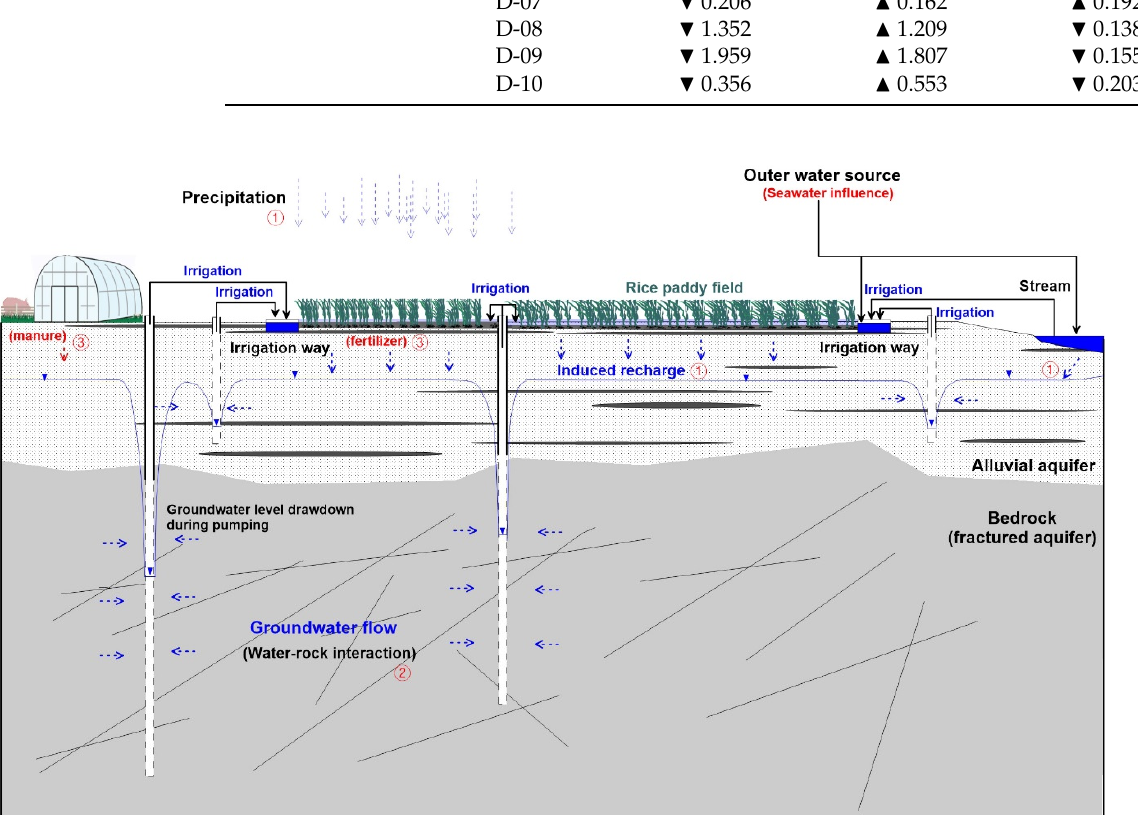
Figure 9. The conceptual diagram to represent the groundwater quality changes during the pumping in the study area. The groundwater in the study area is influenced by ① dilution by precipitation, surface water infiltration and the irrigated water to the rice paddy field, and ② water–rock interaction under groundwater flow control, and ③ contamination by fertilizer and livestock waste. Additionally, high saline groundwaters at some wells are attributed to seawater influence by water supplied from outer water source during the past severe drought in 2018.